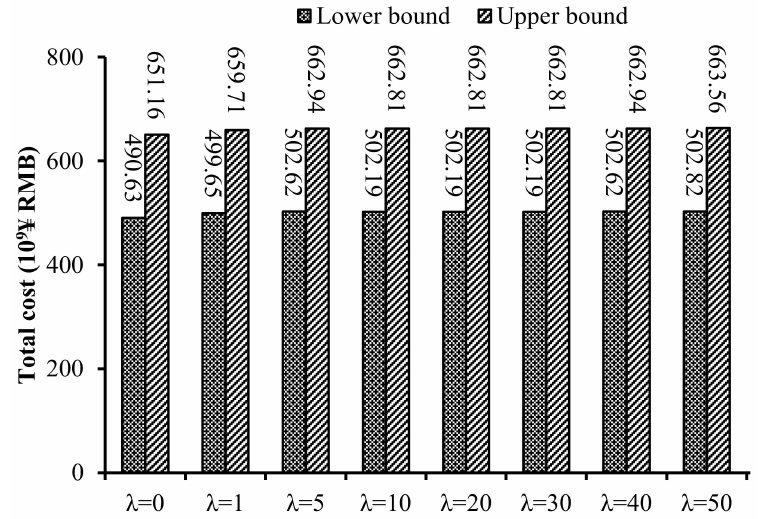
Figure 7. Net system cost under different